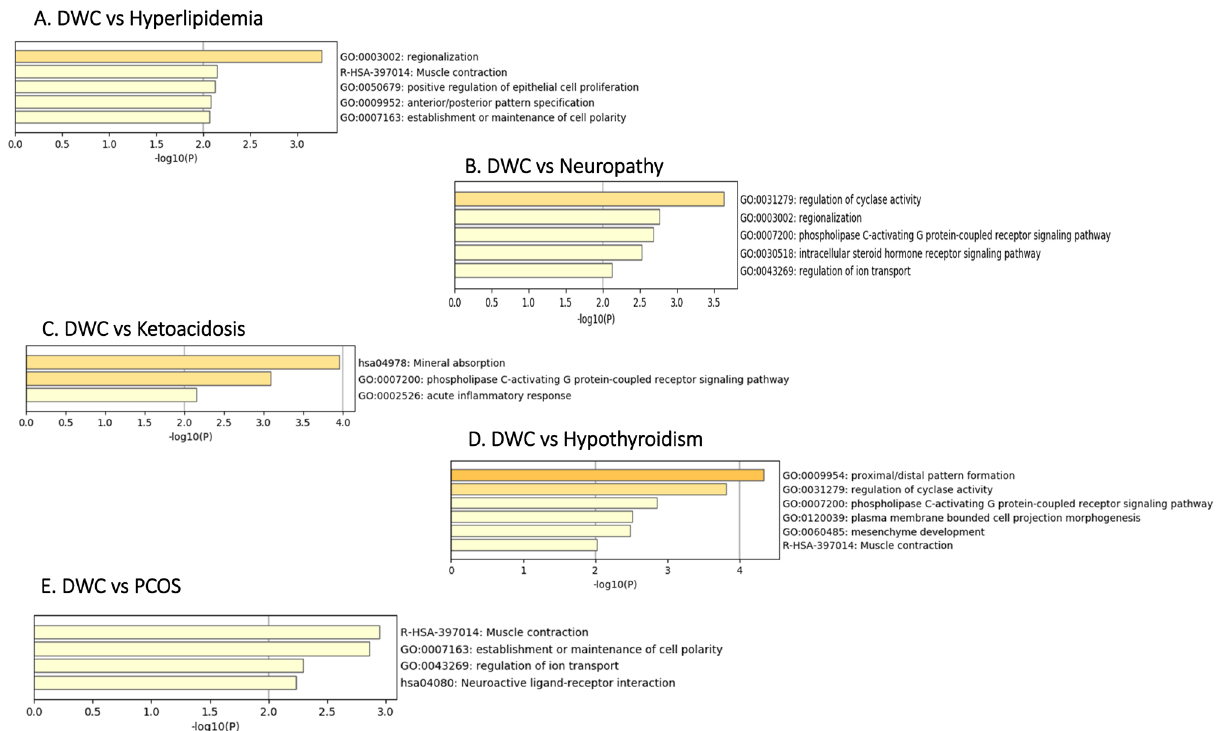
Figure 3. Enriched pathways and functional clusters of upregulated common genes between DWC vs T1DM with complication groups (( A ) Hyperlipidemia, ( B ) Neuropathy, ( C ) Ketoacidosis, ( D ) Hypothyroidism and ( E ) Polycystic Ovarian Syndrome